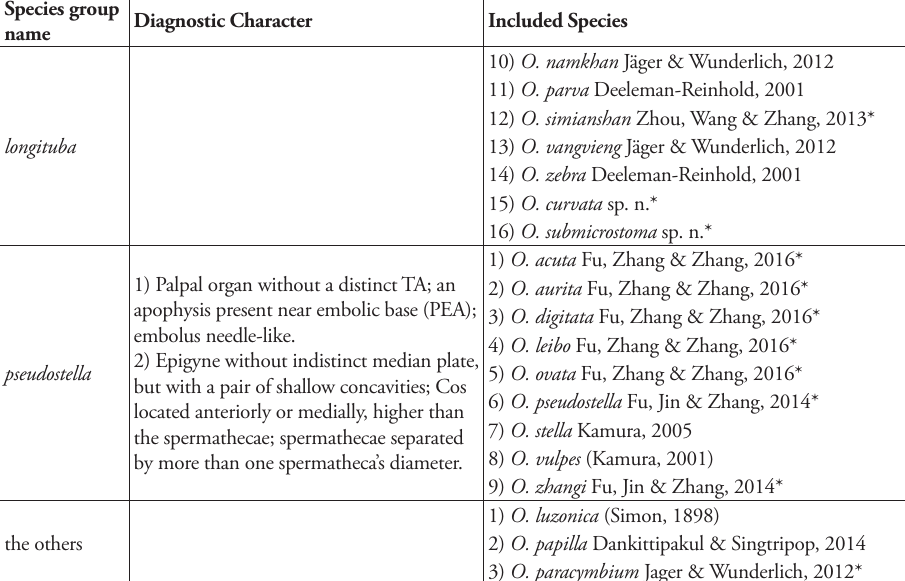
Epigyne (Figs 2E–F, 3D): median plate narrow, with parallel lateral margin;